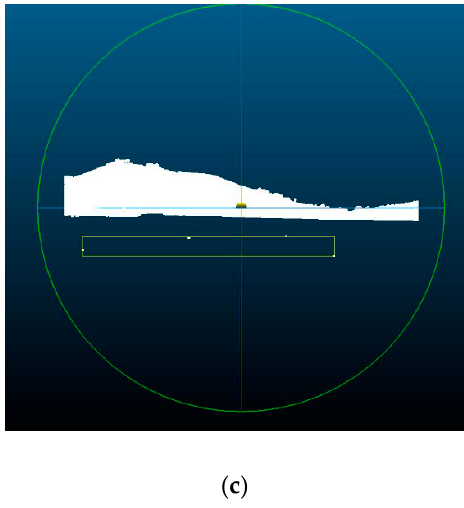
Figure 8. Point cloud in view of vertical section. ( a ) Before (legend on figure shows the SOR filter parameters used as 𝑘 = 6 and 𝑛 = 1); ( b ) after the automatic filtering; (c) manual cleaning processes.